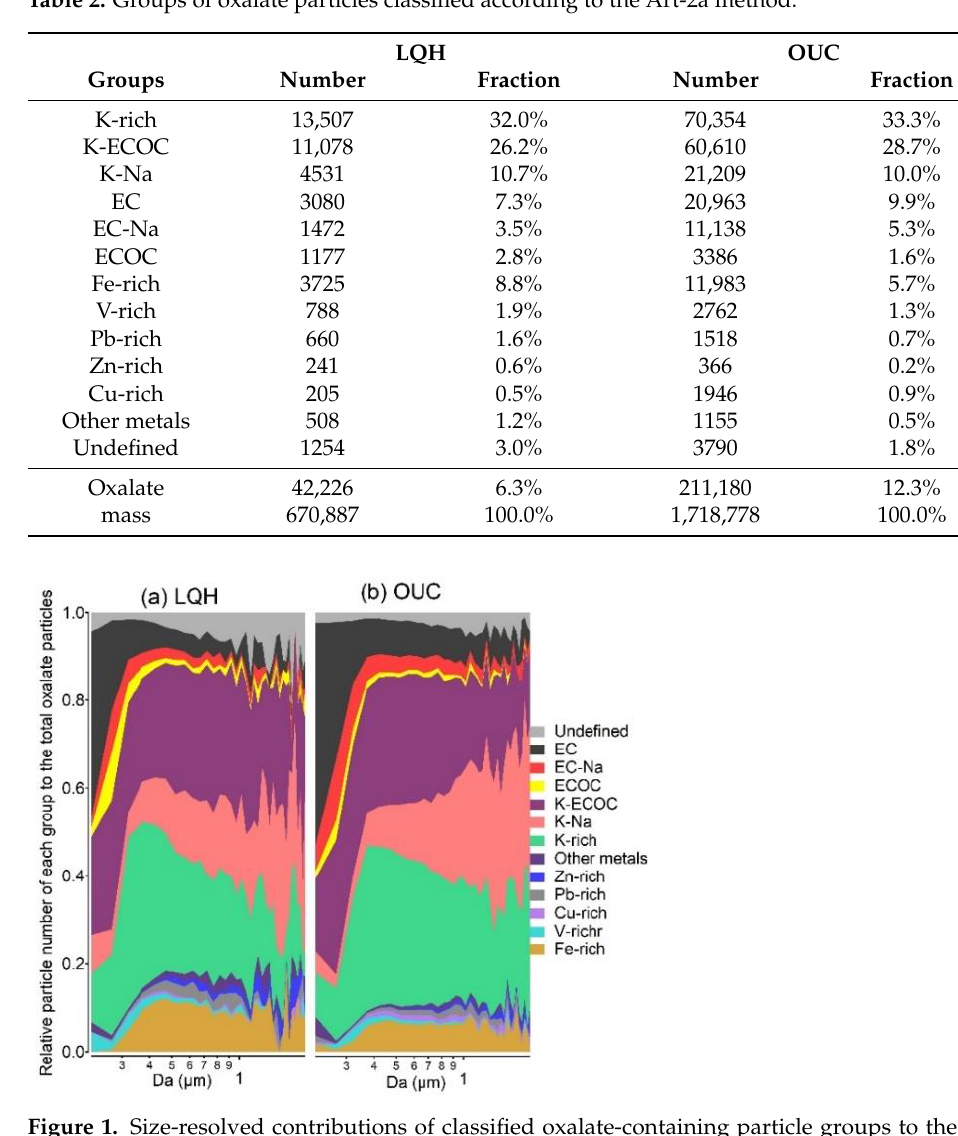
Figure 1. Size-resolved contributions of classified oxalate-containing particle groups to the total oxalate particles (by number percentage) at ( a ) LiuqingHe Scenic Spot [LQH] and ( b ) Ocean University of China [OUC].